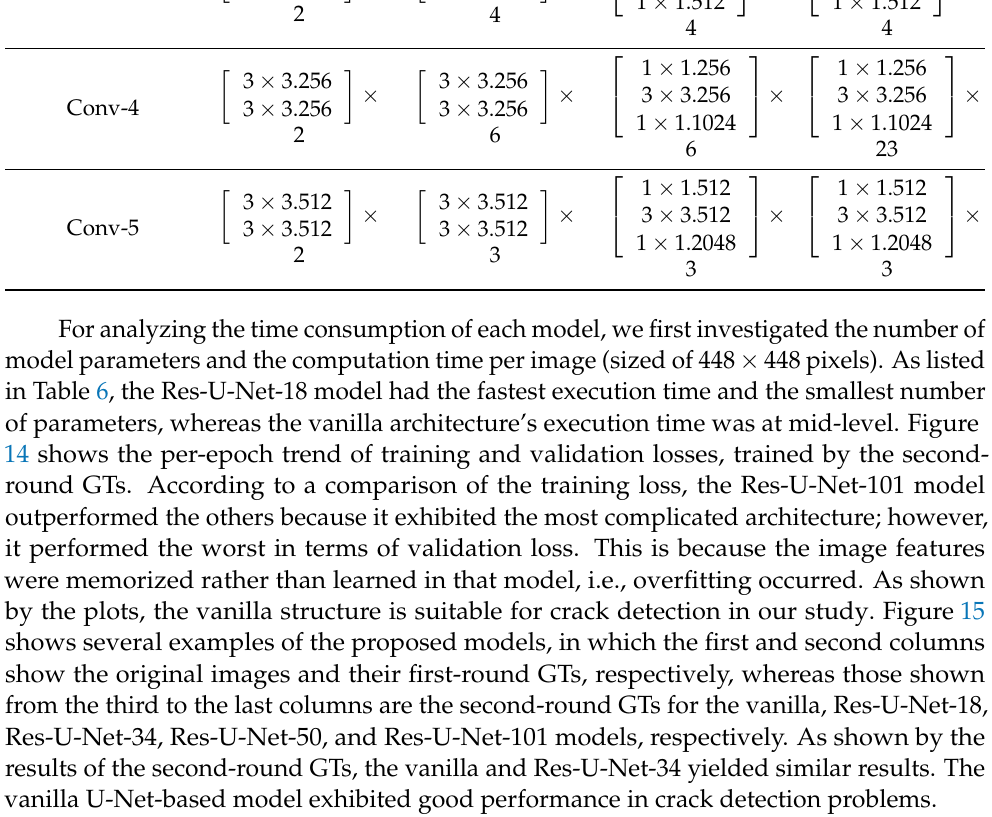
Table 6. The number of parameters and computation time among different encoder backbones.